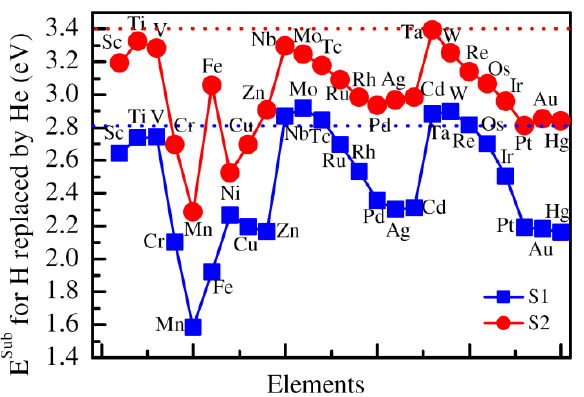
Figure 6. The substitution energy of He replacing H at the closest site of Zr atom, which is substituted by various alloying elements. S1 and S2 suggest the closest and next closest sites to Zr substituted by 3 d , 4 d , and 5 d alloying elements.